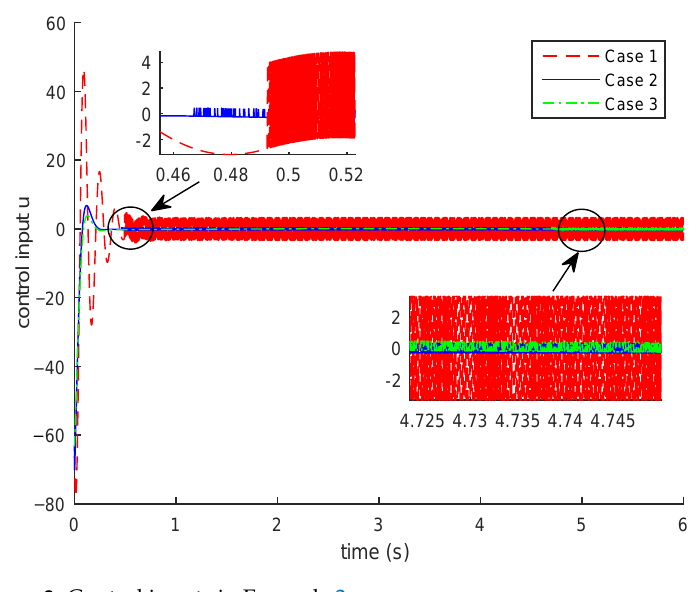
Figure 3. Control inputs in Example 2.